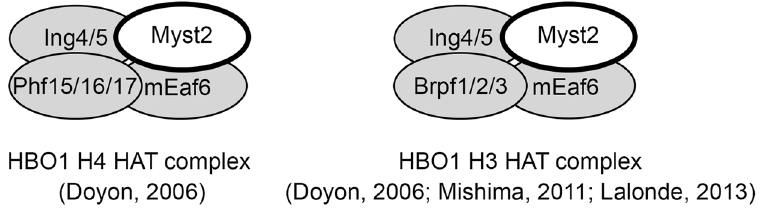
Figure 1. Schematic drawing of H4 and H3 HAT Myst2 complexes. The H4 HAT complex contains Myst2, Eaf6, one of either Ing4 or Ing5, and one of Phf17/Jade1, Phf16/Jade3 or Phf15/Jade2. The H3 HAT complex contains Myst2, Eaf6, one of either Ing4 or Ing5, and one of Brpf1, Brpf2/Brd1 or Brpf3. References describing the complexes are